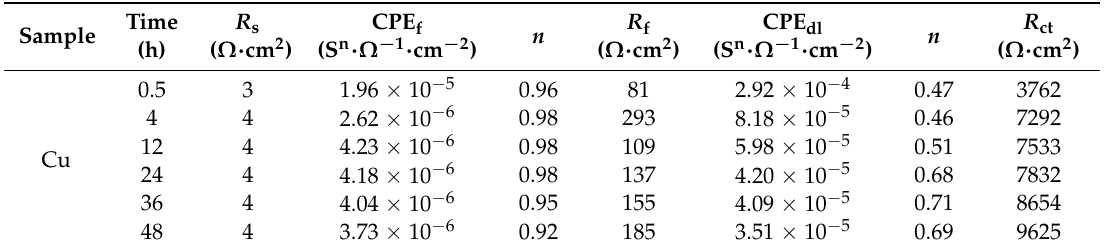
Table 6. Electrochemical impedance parameters of copper electrode with 1-dodecanethiol SAM. Sample Table 7. Electrochemical impedance parameters of H 3 PO 4 -treated copper electrode with 1- dodecanethiol SAM.